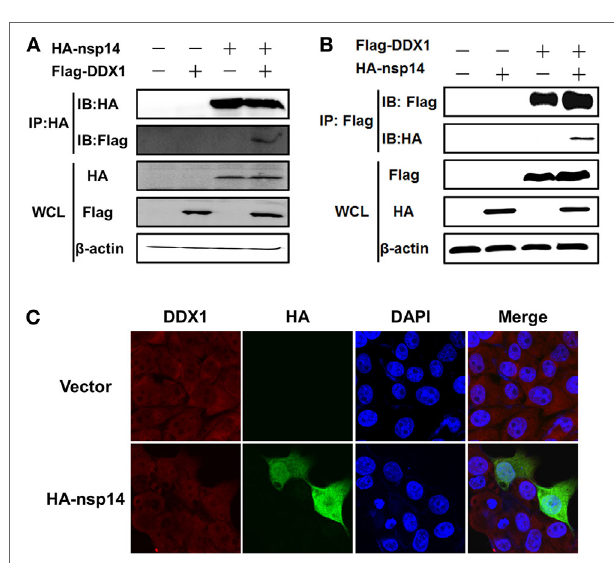
FigUre 4 | Interaction between transmissible gastroenteritis virus nsp14 and DDX1. (a,B) HEK-293T cells were cotransfected with pCAGGS-HA-nsp14 and/or pCMV-Tag2B-DDX1 and/or empty vector(s). Cell lysates were treated with RNase and co-immunoprecipitated with anti-HA (a) or anti-Flag (B) mAbs followed by immunoblot of nsp14 and DDX1 using anti-HA and -Flag mAbs to assess the interaction between nsp14 and DDX1 protein. (c) Colocalization of DDX1 with nsp14. PK-15 cells were transfected with pCAGGS-HA-nsp14 or empty vector. Then, the cells were fixed at 30 h post-transfection and immunostained with anti-HA mouse antibody and anti-DDX1 rabbit antibody to detect the colocalization of DDX1 with nsp14.